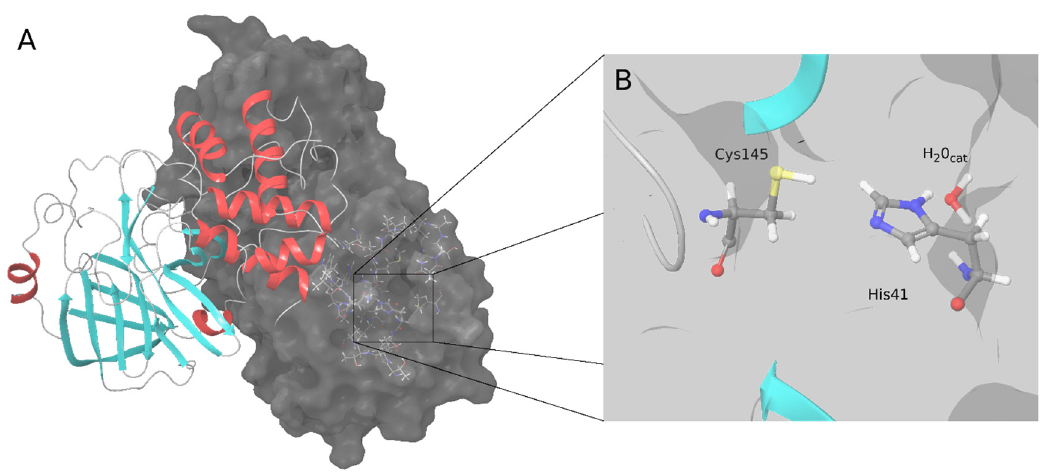
Figure 1. SARS-CoV-2 M-pro structure. ( A ) Biological assembly of the M-pro in its dimeric form. The left protomer is shown in cartoon representation, colored by protein secondary structure, and the right protomer is displayed as a surface. ( B ) Detailed snapshot of the catalytic water, Cys145 and His41.